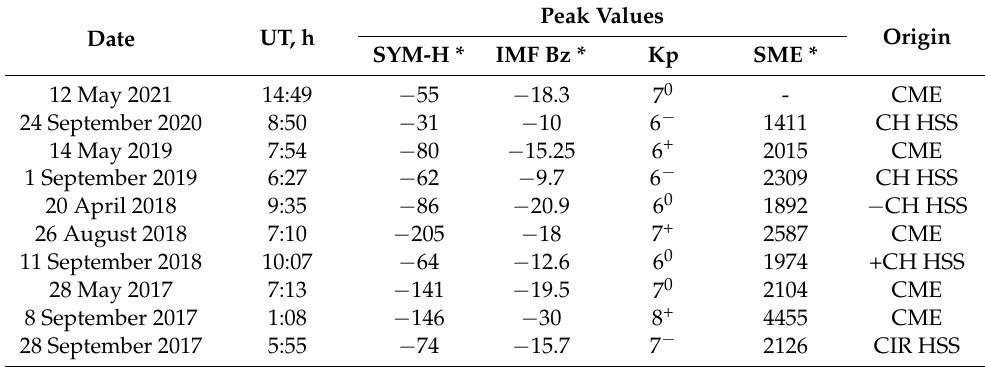
Table 1. The peak values of space weather indices during the strongest storms of 2017-2021.